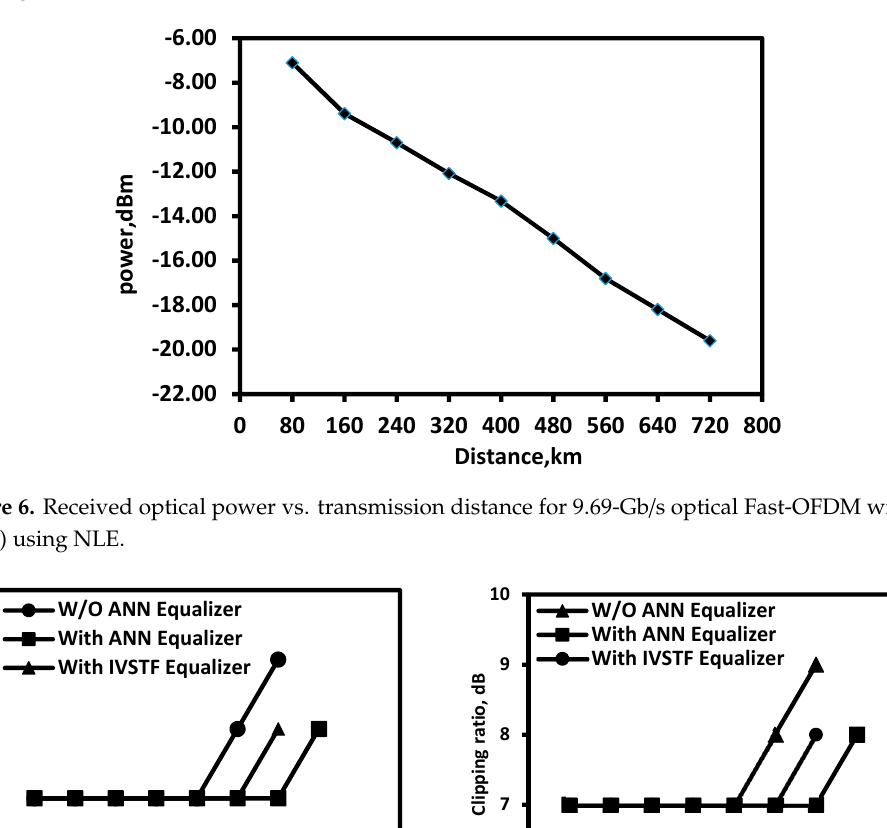
Figure 5. BER vs. optical Fast-OFDM sub-carrier index, with IVSTF-NLE, ANN_NLE and without utilizing ANN at 320 km of fiber transmission.